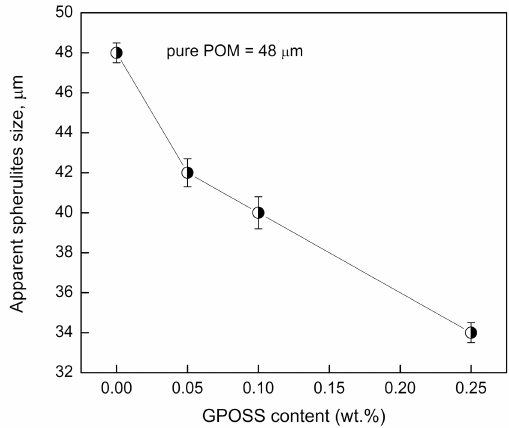
Figure 5. The dependence of the size of spherulites in pure POM and its composites with different GPOSS concentrations. The cooling rate was set to 20 °C/min.